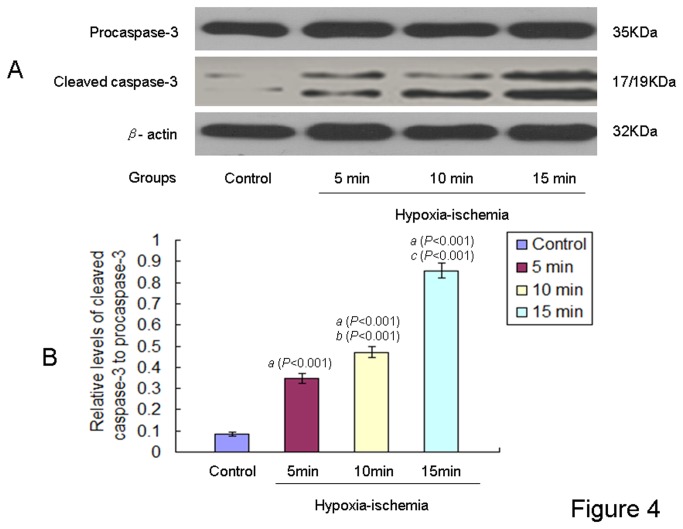
Levels of cleaved caspase-3 to procaspase-3 in the brain of neonatal offspring rats from different groups.A: Representative Westernblots of cleaved caspase-3 and procaspase-3 from brain tissues of offspring rats with or without ischemic injuries were showed. B: Levels of cleaved caspase-3 to procaspase-3 in the brain of neonatal offspring rats from different groups (n= 12 in each group) at PND 1 were calculated relative to that of β-actin. The results were expressed as mean ± S.D.. a: compared with the control group; b: compared with the 5 min HIE group; c: compared with the 10 min HIE group. All P values were <0.001.